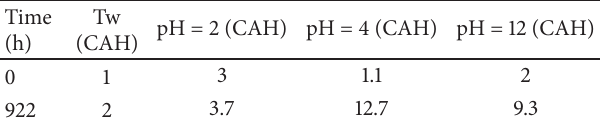
Table 1: Contact angle hysteresis of the prepared